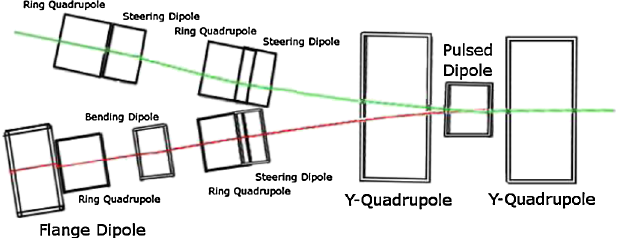
FIG. 2. (Color) A diagram of one particular operating point steering the beam through both injection (green) and recircula- tion (red)